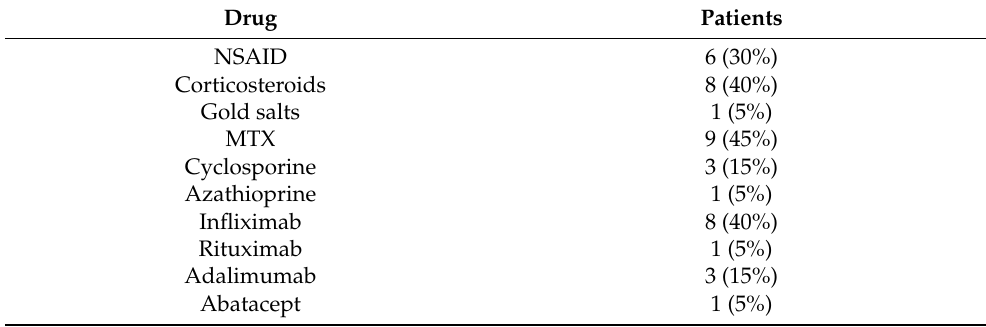
Table 3. Systemic treatments used in JIA-uveitis